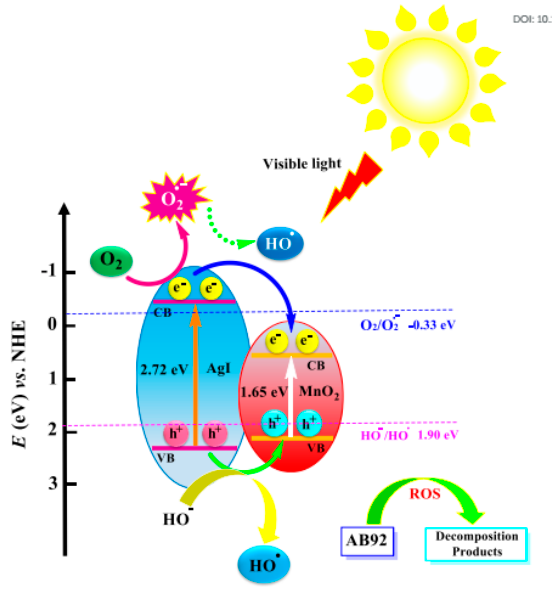
Figure 6. Mechanism for the separation electron / hole pairs in the α -MnO 2 / AgI